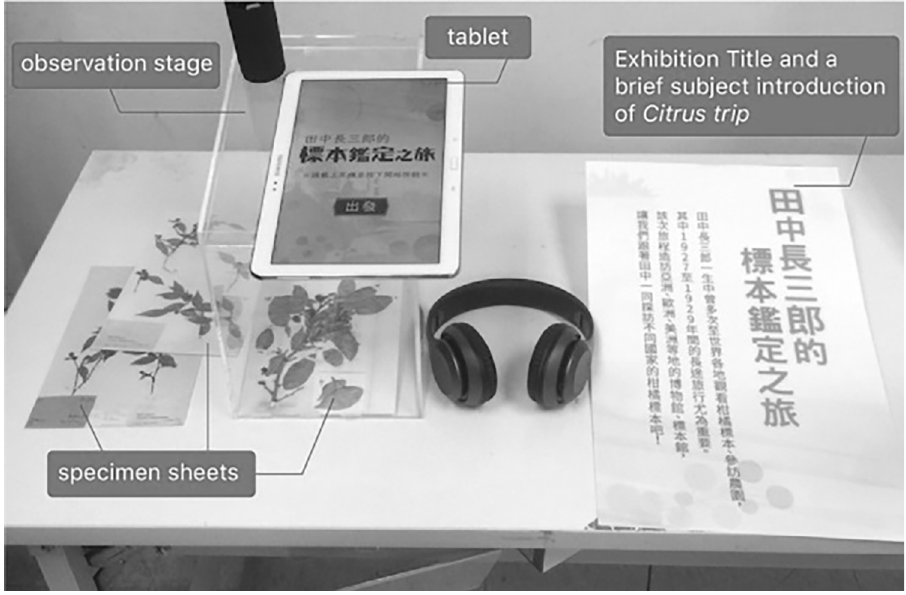
Fig 1. The experiment scenario. Note: The authors created this figure for this article; it is not based on any previously copyrighted